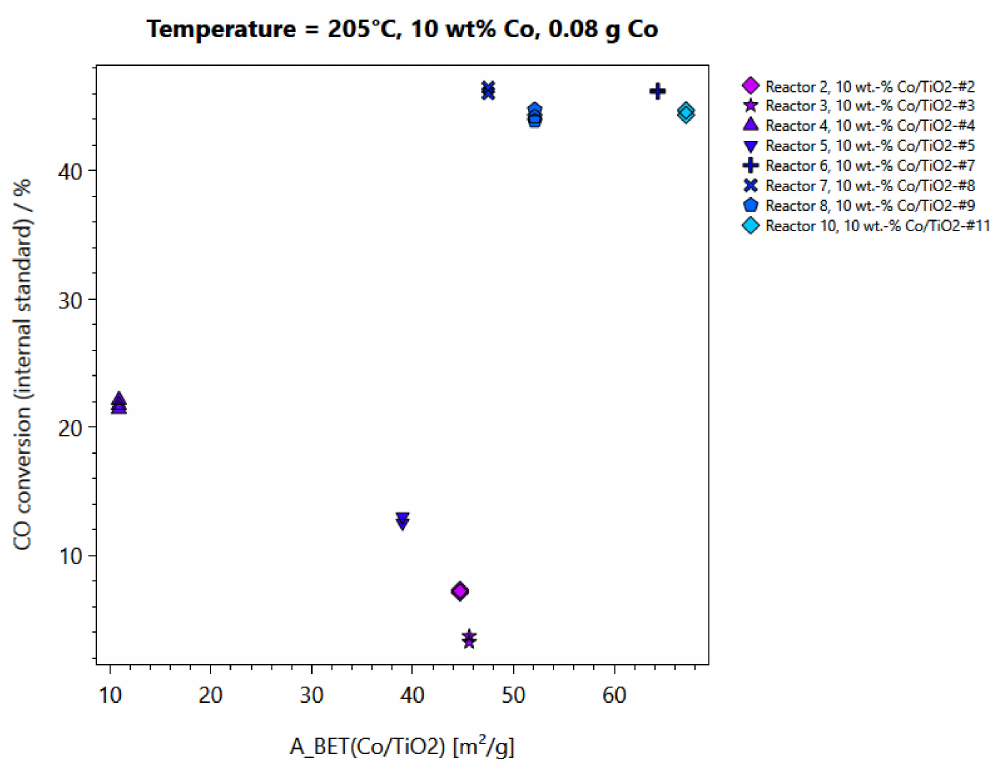
Figure 5. Correlation of specific surface area and conversion of